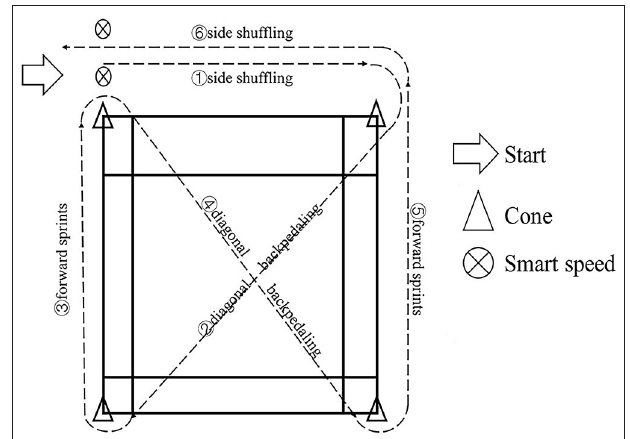
FIGURE 2 | Modified Southeast Missouri (SEMO) test.